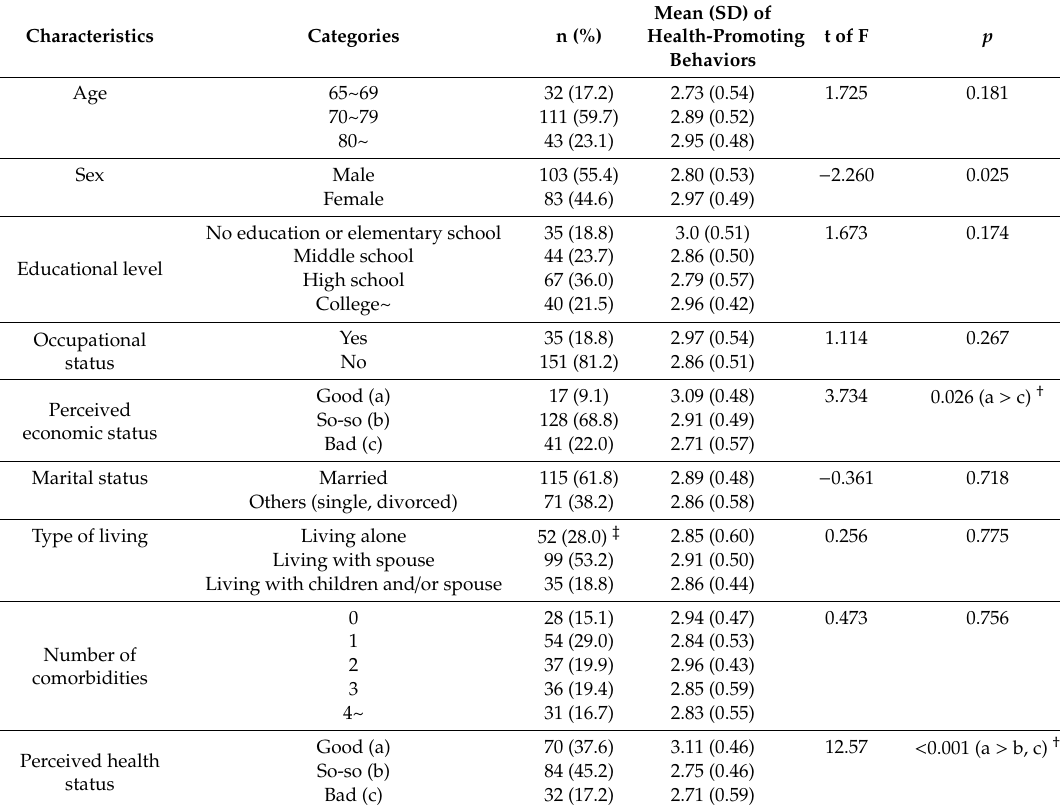
Table 3. Sample characteristics (N = 186).